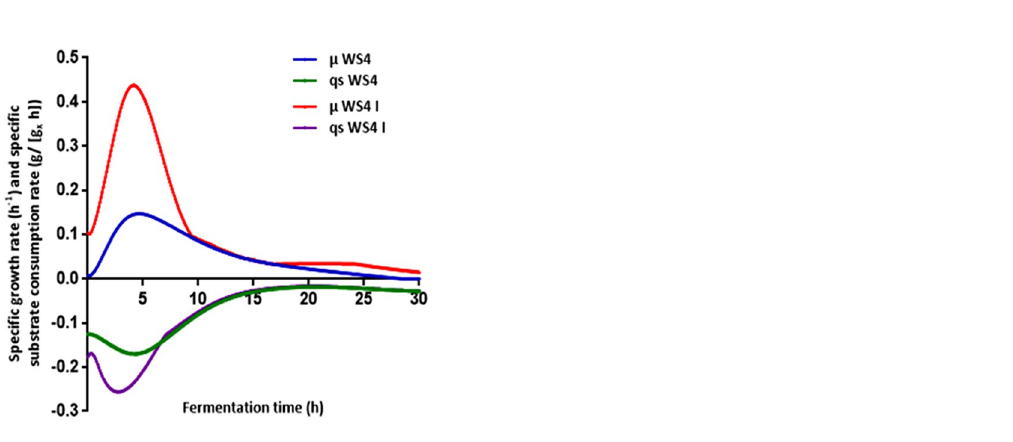
Figure 6. Specific growth rate (µ) and specific substrate consumption rate (q S ) during P. temperata fermentation in WS4 and WS4